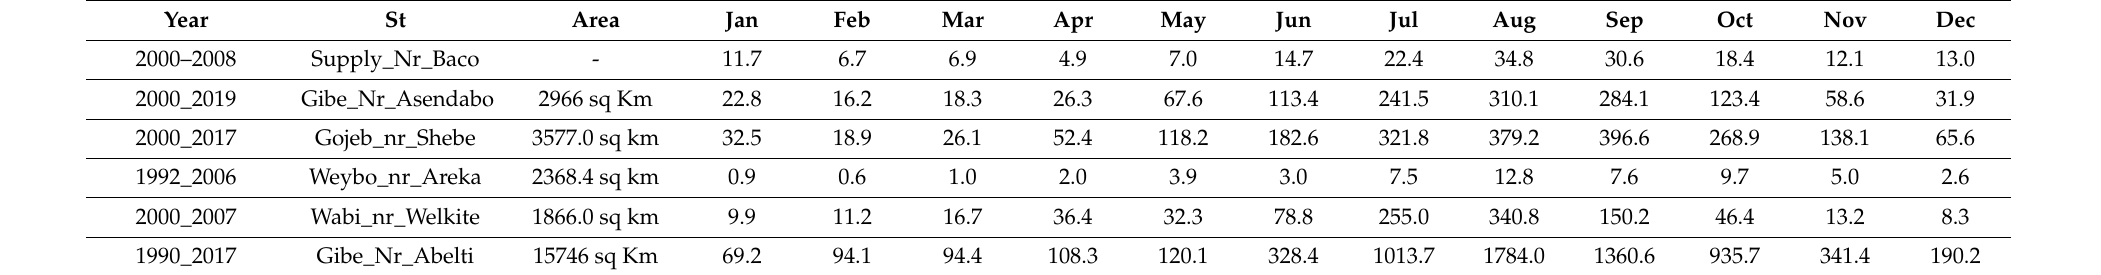
Table 4. Average monthly river inflow (Mm 3 /month).